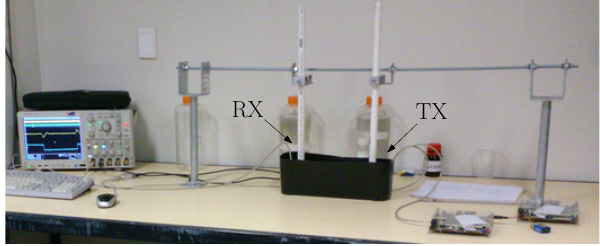
Figure 3: Photograph of experimental setup, show- ing the transmitter and receiver electrodes sus- pended in the phantom solution.